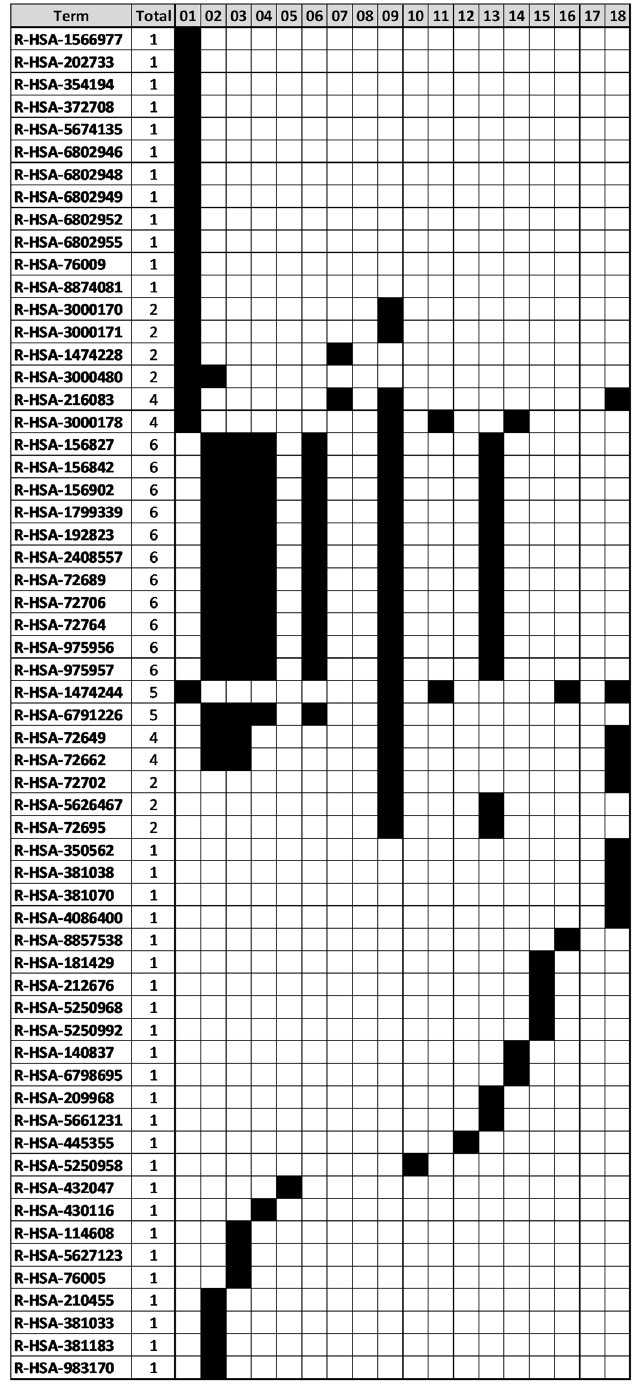
Figure 7. Biological Enrichment at Each Layer of SVD-Entropy Threshold Relaxation. Specific Reactome pathway enrichment (FDR < 0.01) at each level of feature selection (01–18) is shown as a black box. The total number of shared functions across all magnifications is